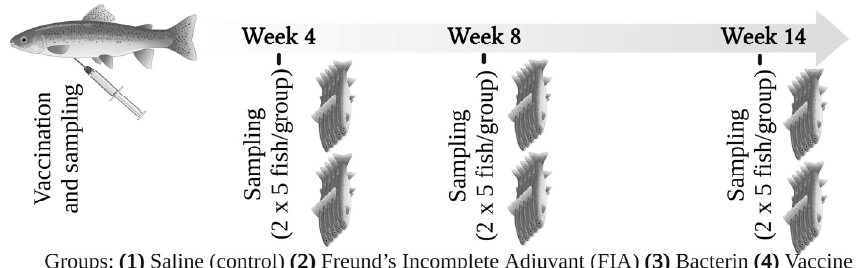
Figure 1. Experimental design and timeline of the vaccination trial and sampling. A total of 10 (2 × 5) fish (n = 10) were sampled from each group at each sampling time point.